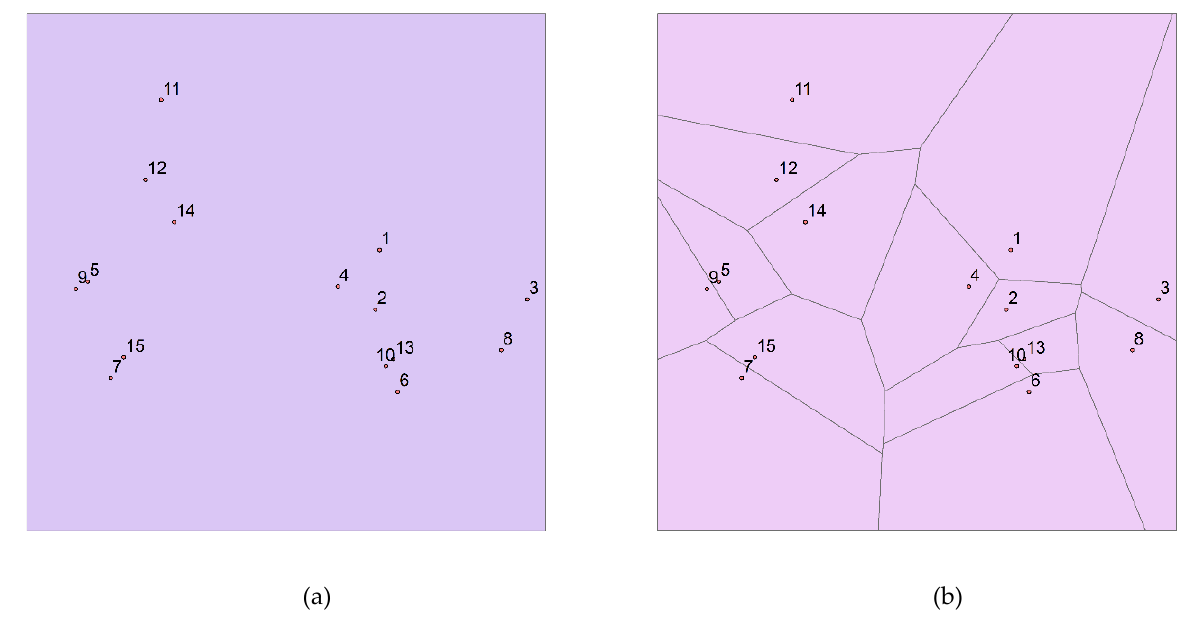
Figure 2. A schematic plot showing the Thiessen polygon generated from the soil moisture stations. ( a ) TxSON stations (stations 1–15) within Grid 2, the dimension of the grid is 9 km by 9 km; ( b ) Thiessen polygons generated from the stations (stations 1–15).